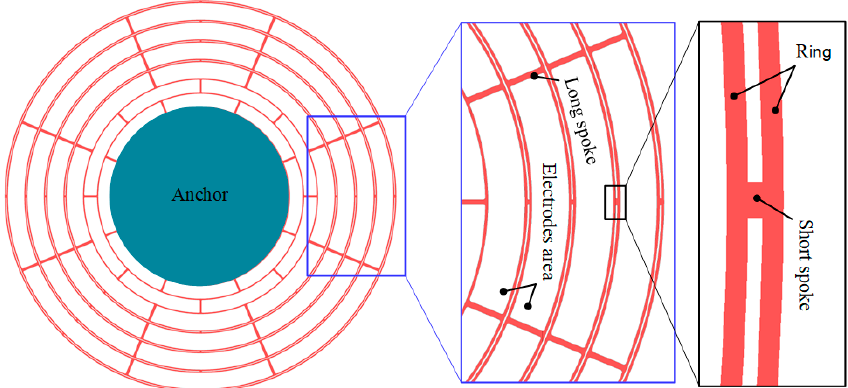
Figure 1. Geometry of the disk resonator gyroscope